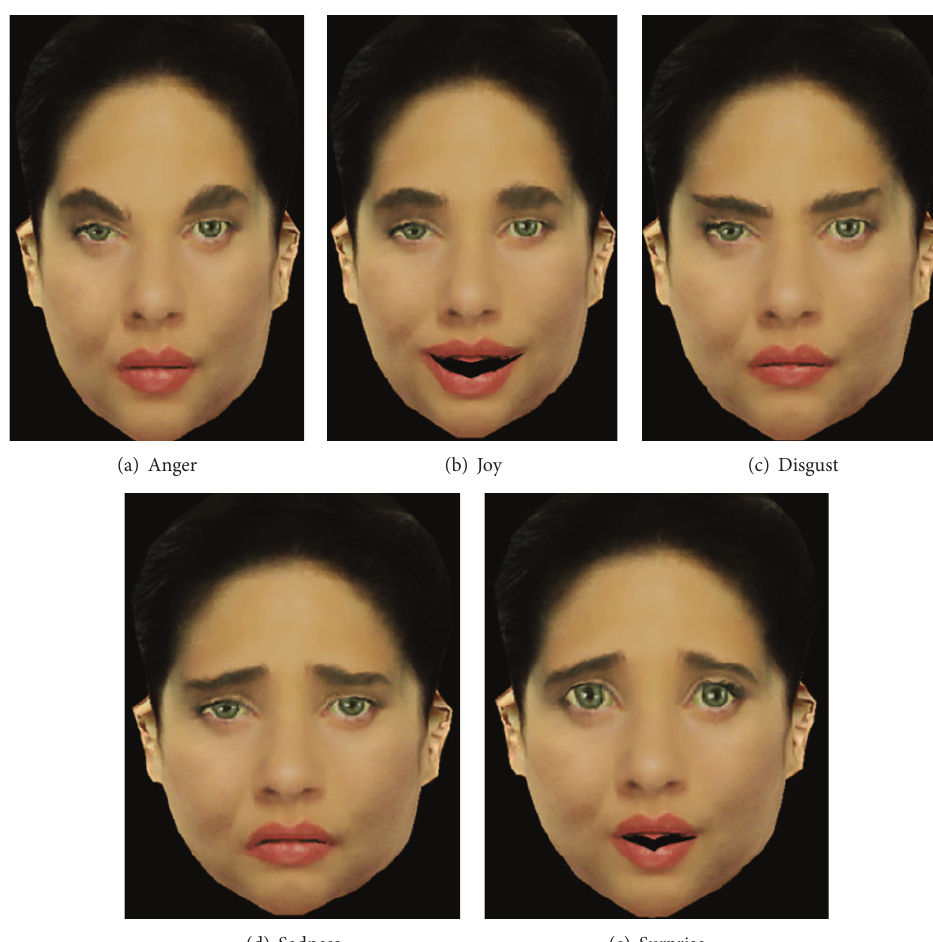
Figure 7: Five basic 3D expressions’